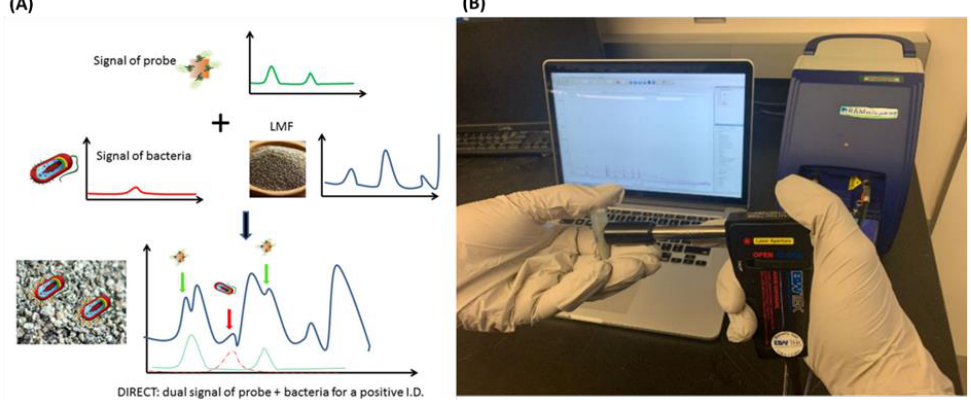
Figure 5. Scheme ( A ) and experiment setup ( B ) of a dual immunological Raman-enabled crosschecking test for detection of contamination in LMF. Reprinted with permission [223], copyright 2020, MDPI.